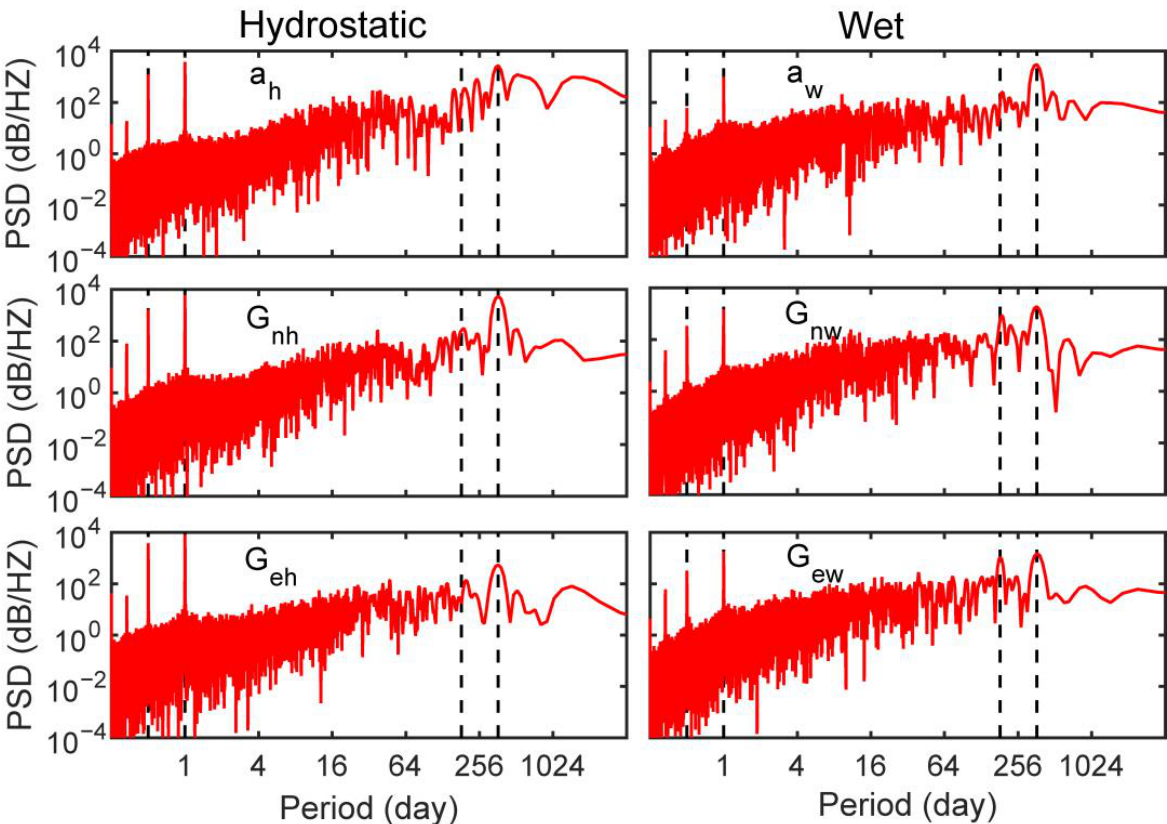
Figure 3. Variation characteristics for the mapping function coefficients and horizontal gradients at the AREG station. The four dash lines from left to right mark the semi-diurnal, diurnal, semi-annual, and annual periods, respectively.